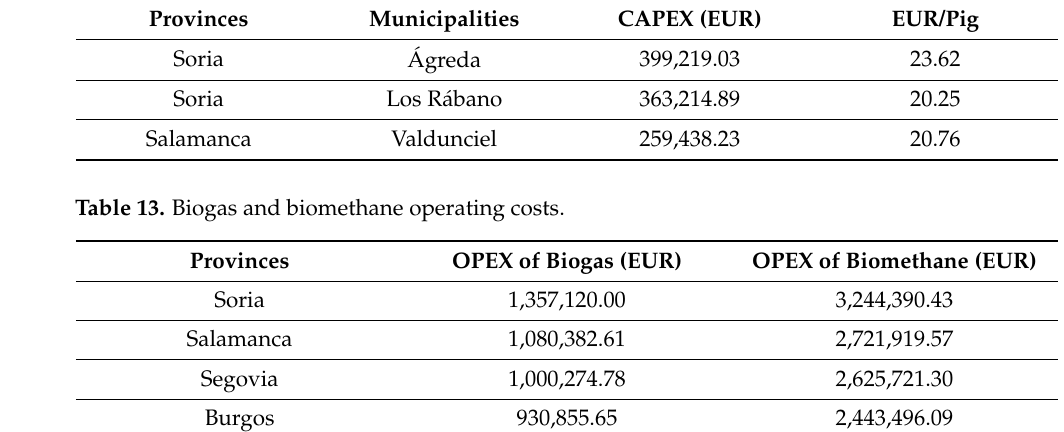
Table 12. Cost of biomethane production with Membrane Separation.